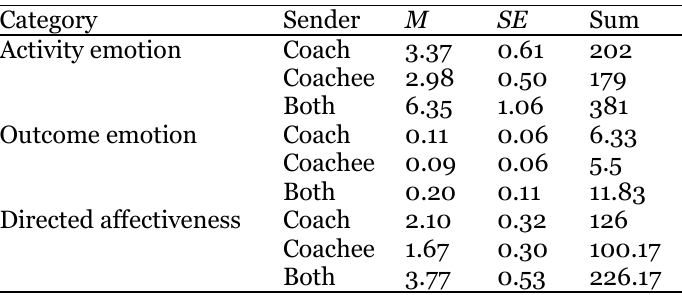
Descriptive Statistics for Emotional Presence Category